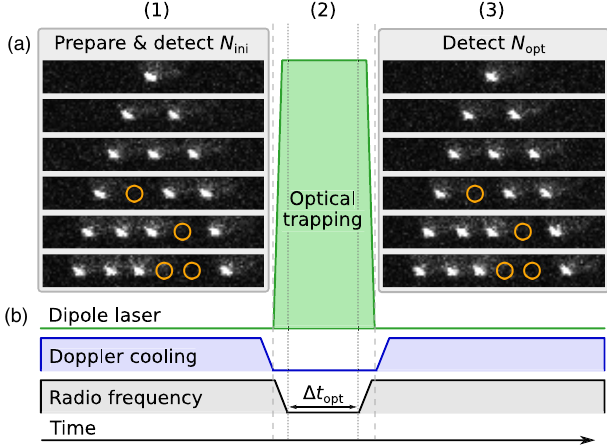
FIG. 2. Demonstrating the persistence of Coulomb order for an increasing number of optically trapped ions. (a) Fluorescence ¼ 1 … 6 Ba þ ions are images of Coulomb crystals with N ini ≥ 4 , recorded before and after optical trapping of N . For N opt ini the gaps marked by orange circles reveal the presence of dark ions, which appear at initial random lattice sites after Doppler and sympathetic cooling. (b) The experimental protocol (not to scale) consists of three steps: (1) we detect the initial configuration and ion number N while Doppler cooling the ions; (2) the ions are ini transferred into the dipole trap by turning off the rf field and cooling lasers for the optical trapping duration Δ t , keeping opt the electrostatic potential; and (3) we again detect the number and final configuration of all remaining ions in the rf trap.